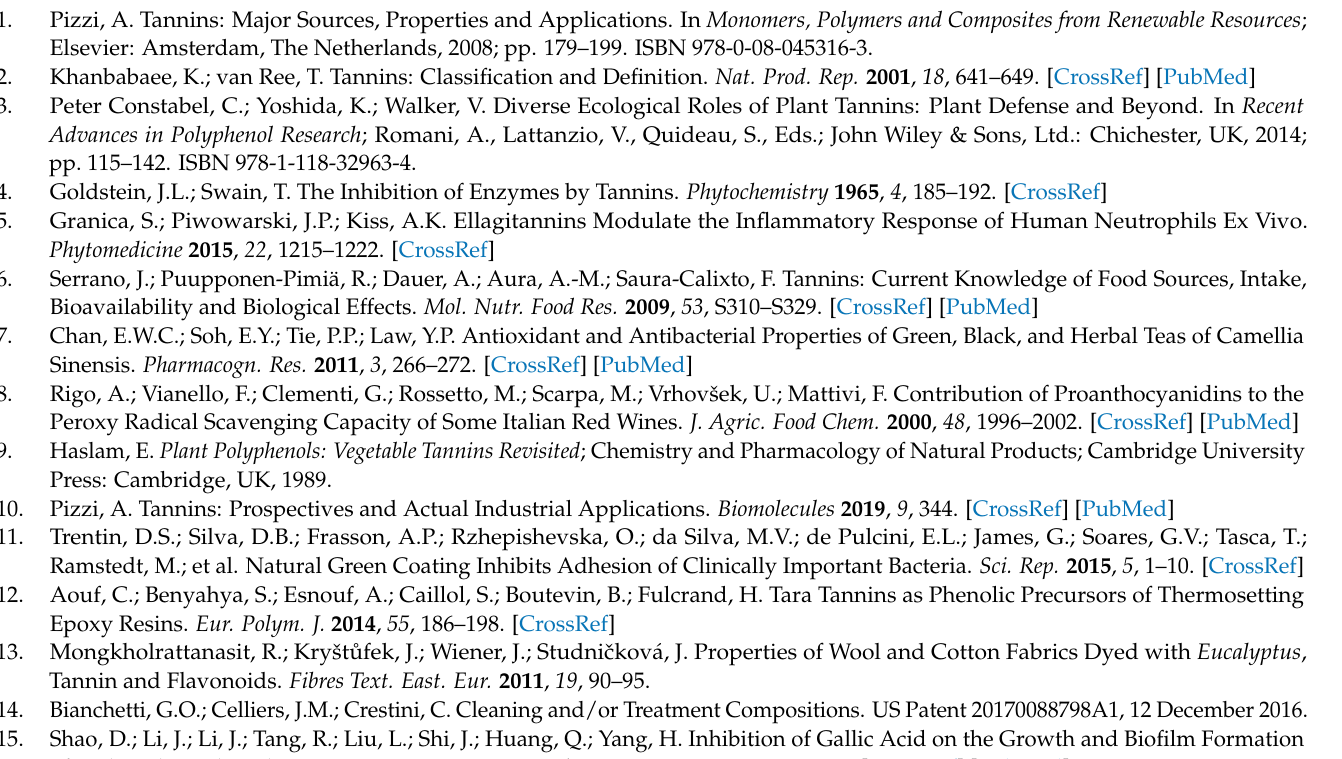
( Sb ). Figure S13: NMR analyses of Tanal 01 ( Ta-01 ): (A) 31 P NMR; (B) 1 H- 13 C HSQC. Figure S14: MALDI-ToF analyses of Tanal-01 ( Ta-01 ). Figure S15: NMR analyses of Tanal 02 ( Ta-02 ): (A) 31 P NMR; (B) 1 H- 13 C HSQC. Figure S16: MALDI-ToF analyses of Tanal-01 ( Ta-02 ). Figure S17: NMR analyses of Tanal 04 ( Ta-04 ): (A) 31 P NMR; (B) 1 H- 13 C HSQC. Figure S18: MALDI-ToF analyses of Tanal-01 ( Ta-04 ). Figure S19: NMR analyses of TARA POLV TIPO A ( Ct ): (A) 31 P NMR; (B) 1 H- 13 C HSQC. Figure S20: MALDI-ToF analyses of TARA POLV TIPO A ( Ct ). Figure S21: NMR analyses of VEGETAN CN POLVERE ( Cs ): (A) 31 P NMR; (B) 1 H- 13 C HSQC. Figure S22: MALDI-ToF analyses of VEGETAN CN POLVERE ( Cs ). Table S1: Results of qualitative 1 H- 13 C HSQC analyses of commercialised condensed tannins according to literature reports. Table S2: MALDI-ToF analysis of commercialised condensed tannins. Table S3: Results of qualitative 1 H- 13 C HSQC analyses of commercialised hydrolysable tannins according to literature reports. Table S4: MALDI-ToF analysis of commercialised hydrolysable